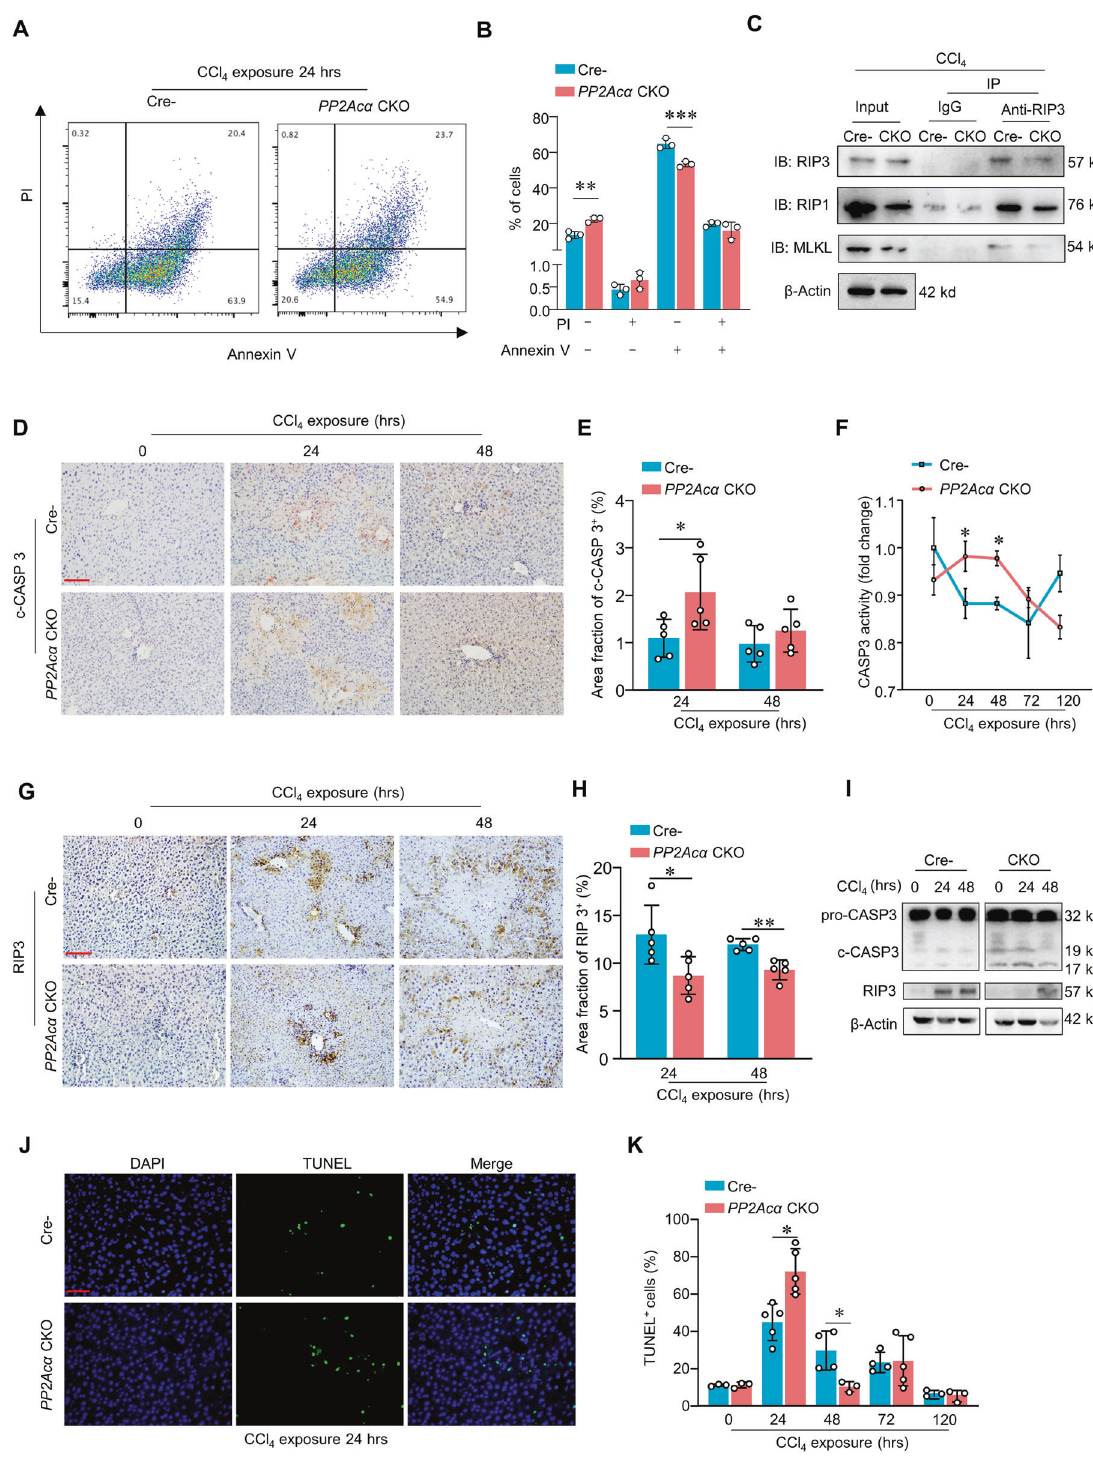
Fig. 4 Conditional knockout of PP2Ac α promotes apoptosis over necroptosis in CCl 4 -induced ALI livers. Representative images ( A ) and analysis ( B ) of fl ow cytometry of Annexin V and PI signals in primary hepatocytes isolated from Cre − or PP2Ac α CKO mice treated with CCl 4 for 24h. ( n = 3) C Co-immunoprecipitation was conducted to detect the interactions among RIP1, RIP3, and MLKL in primary Cre − and PP2Ac α CKO hepatocytes with PBS, TS, TSZ, and CCl 4 treatment. Representative images of IHC staining of liver c-CASP3 ( D ) (scale bar, 100 μ m) and quanti fi cation of liver c-CASP3-positive area ( E ) in Cre − and PP2Ac α CKO mice treated with CCl 4 24h and 48h ( n = 5). F Caspase-3 activity in liver tissues from Cre − and PP2Ac α CKO mice from 0 to 120h after CCl 4 induction ( n = 3). Representative images of IHC staining of liver RIP3 ( G ) (scale bar, 100 μ m) and quanti fi cation of liver RIP3-positive area ( H ) in Cre − and PP2Ac α CKO mice treated with CCl 4 24h and 48h ( n = 5). I Immunoblotting showed the liver Pro-Caspase-3 (pro-CASP3), c-CASP3, RIP3 in Cre − and PP2Ac α CKO mice with CCl 4 induction. Representative images ( J ) (scale bar, 100 μ m) and quanti fi cation of TUNEL staining ( K ) ( n = 3 – 5) of hepatocytes from Cre − and PP2Ac α CKO mice at indicated time after CCl 4 induction. * p <0.05, ** p <0.01, *** p <0.001, one-way ANOVA followed by Tukey ’ s multiple comparisons test ( B , E , F , H and K ). Data are represented as mean±SD.